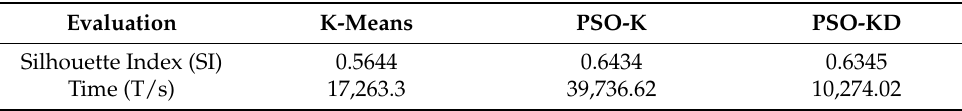
Table 6. Evaluation of clustering